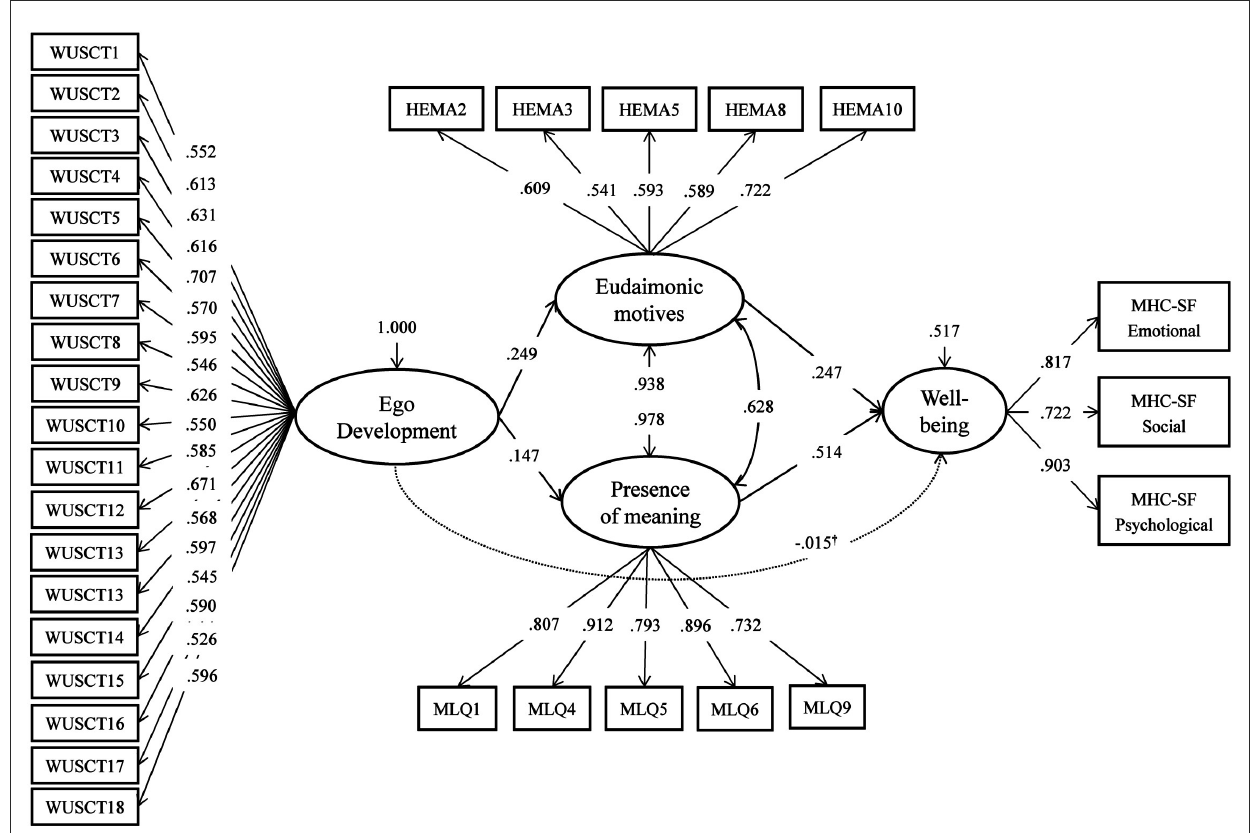
FIGURE1 Parameters of the parallel mediation model. χ 2 = 627.22, df = 428, p < 0.001; CFI = 0.973; RMSEA = 0.036, 90% CI (0.030; 0.042); SRMR = 0.048. Standardized coefficients are shown; all the parameters are significant at p < 0.05, except for those marked †